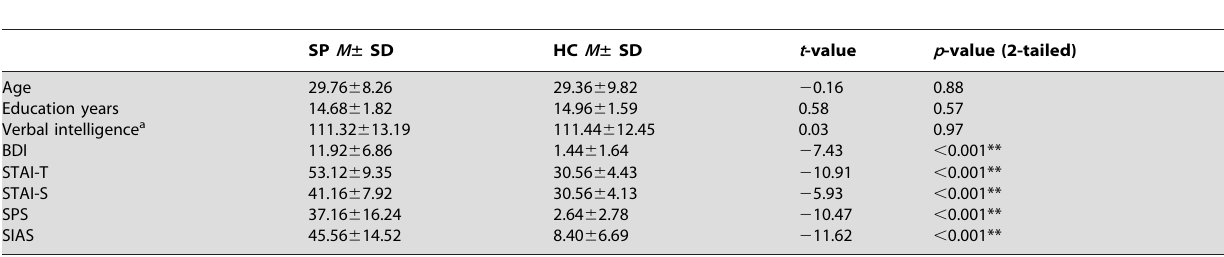
Table 1. Mean differences for patients with social phobia (SP) and healthy controls (HC) concerning age, verbal intelligence, depression (BDI), Trait- and State anxiety (STAI-T and STAI-S) and social phobia symptoms (SPS/SIAS).